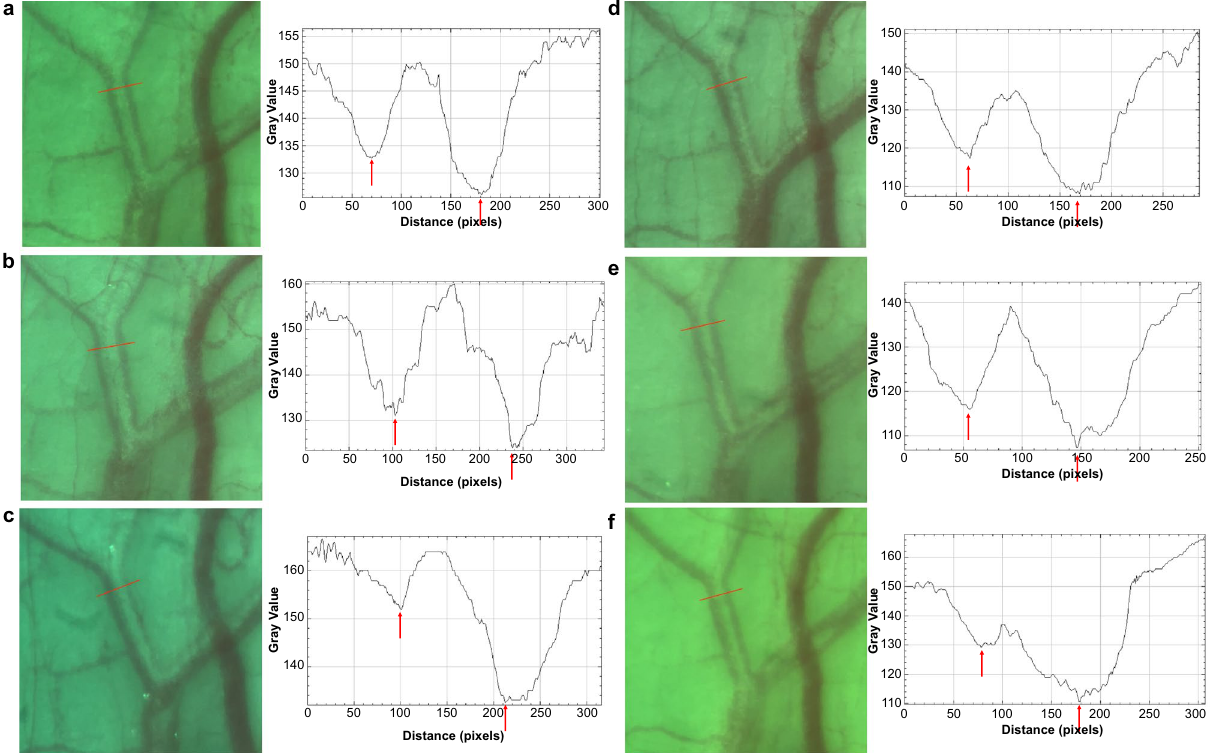
Figure 3. The graph of a representative case with ripasudil and latanoprost instillations. ( a ) before ripasudil instillation. ( b ) 2 h after ripasudil instillation. ( c ) 8 h after ripasudil instillation. ( d ) before latanoprost instillation. ( e ) 2 h after latanoprost instillation. ( f ) 8 h after latanoprost instillation. The line presents the measurement position. The arrow presents the minimum intensity.